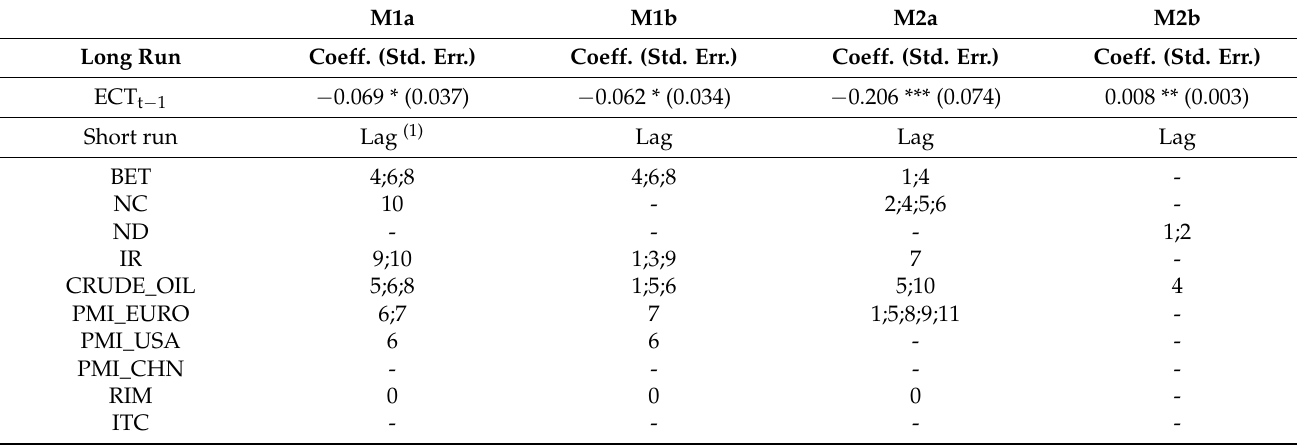
Table 8. Granger causality test